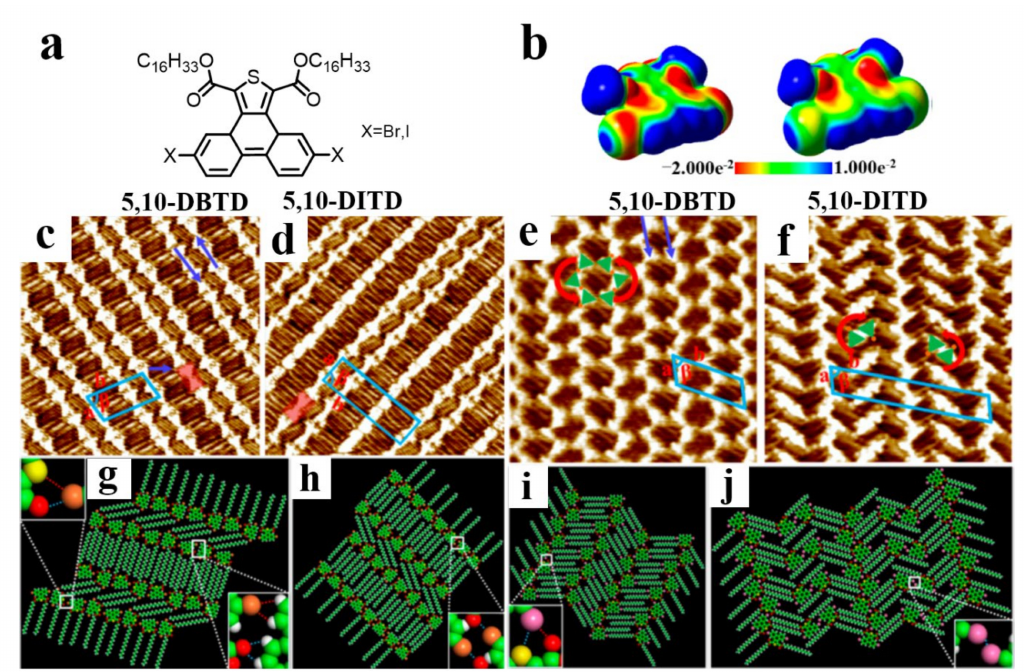
Figure 15. ( a , b ) Chemical structures of 5,10-DBTD and 5,10-DITD, and their calculated 3D ESP maps. ( c , d ) High-resolution STM images of vertebra-like (2.5 × 10 − 4 M) and alternate vertebra-like (9.7 × 10 − 5 M) patterns of 5,10-DBTD adlayers at the 1-phenyloctane / HOPG interface, respectively. ( e , f ) High-resolution STM images of honeycomb-like (6.6 × 10 − 4 M) and alternate chiral (8.2 × 10 − 5 M) patterns of 5,10-DBTD adlayers at the 1-phenyloctane / HOPG interface, respectively. Scanning area: 20 × 20 nm 2 . ( g – j ) Proposed structural models of ( c – f ). Insets show the intermolecular interactions. Reproduced from [89] with permission from the American Chemical